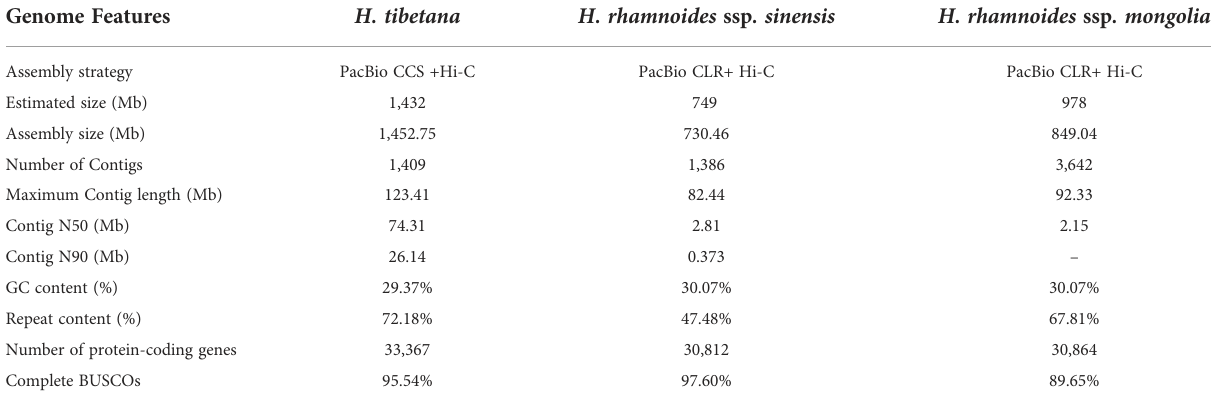
TABLE 1 Statistics of the genome assembly and